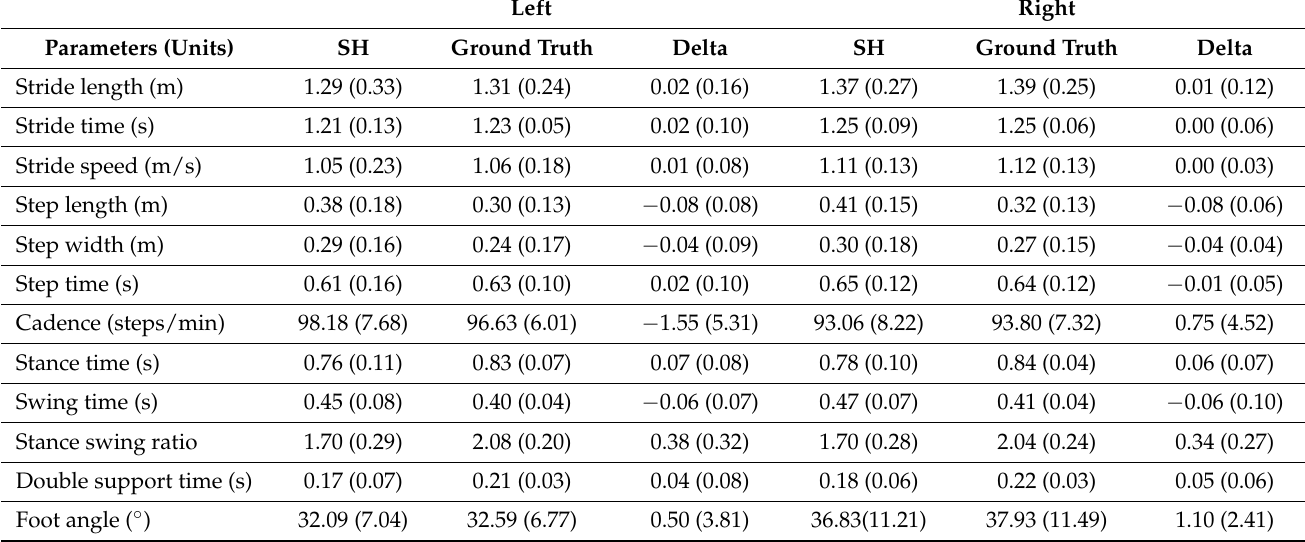
Table 9. Stride parameters for participant one from the Smart Hallway (SH) compared to ground-truth foot-event stride parameters for the walking-curve test (mean and standard deviation in